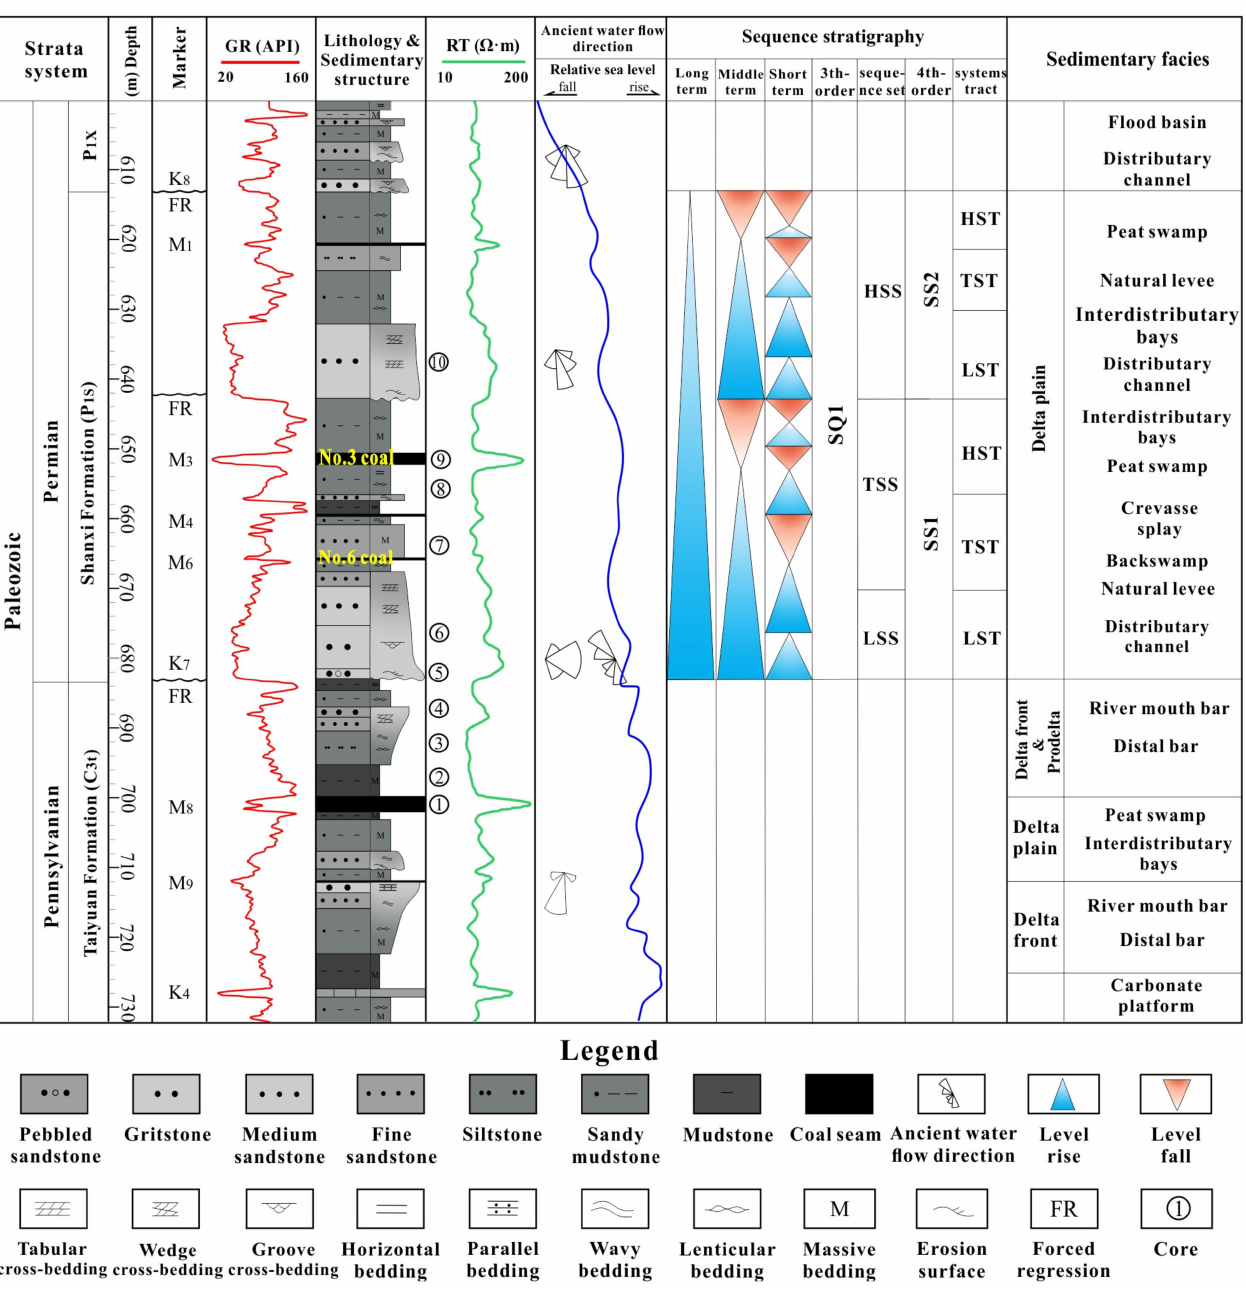
Figure 2. Main stratigraphy, logging curve, lithology, sedimentary facies, sedimentary structure and sequence stratigraphic framework of the coal-bearing strata of well 3-193 in the Qinshui Basin. HSS: high-stand sequence sets; TSS: transgressive sequence sets; LSS: low-stand sequence sets; HST: high- stand systems tract; TST: transgressive systems tract; LST: low-stand systems tract; P 1X : Xiashihezi Formation. Note that the ancient water flow was modified from Ge et al.,